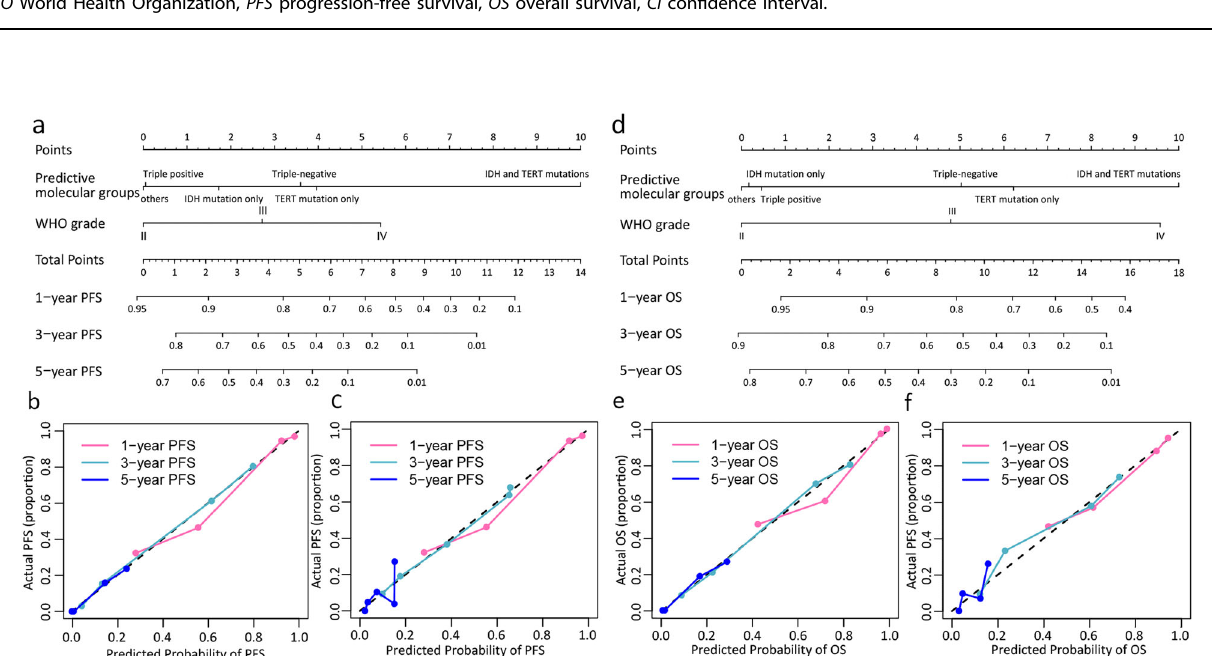
Fig. 2 The nomograms and calibration curves. ( a ) Combined nomogram incorporating the predictive molecular groups and WHO grade for predicting PFS; ( b - c ) Calibration curves of the nomogram ( a ) in the training and validation datasets, respectively; ( d ) Combined nomogram incorporating the predictive molecular groups and WHO grade for predicting OS; ( e - f ) Calibration curves of the nomogram ( d ) in the training and validation datasets,